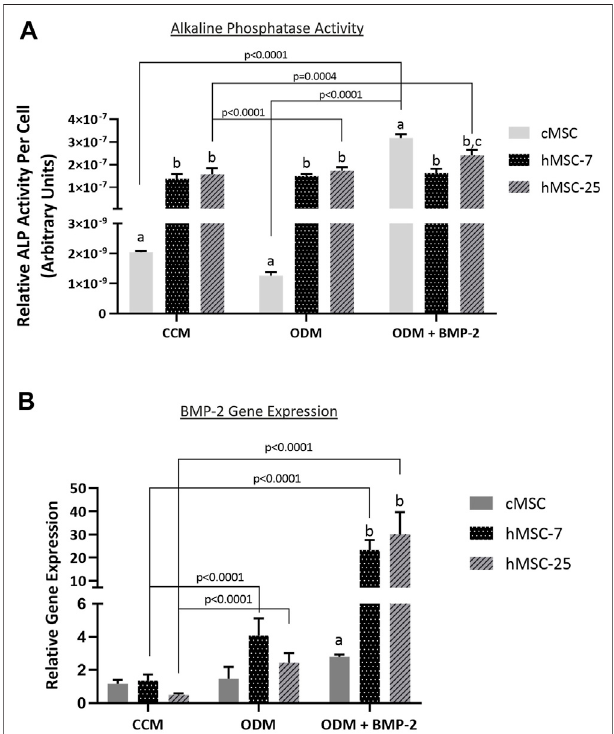
FIGURE 6 | Alkaline phosphatase (ALP) activity and endogenous BMP- gene expression in cMSCs and hMSCs. (A) : cMSCs and two preparations of hMSCs were examined using the classic ALP activity assay. Cells were cultured for 7 days in control (CCM), osteogenic medium (ODM), or osteogenic medium containing 100 ng/ml BMP-2 (ODM + BMP-2). ALP activity for each well was normalized to cell number by DNA quanti fi cation. Data were analyzed with two-way ANOVA and Tukey ’ s post hoc test. cMSCs exhibited minimal ALP activity in CCM or ODM, but responded robustly when cultured in ODM + BMP-2. In contrast, ALP activity for both preparations of hMSCs was robust regardless of culture conditions. These results are consistent with prior work and demonstrate important differences between cMSC and hMSC in vitro osteogenic differentiation. (B) : qPCR results for